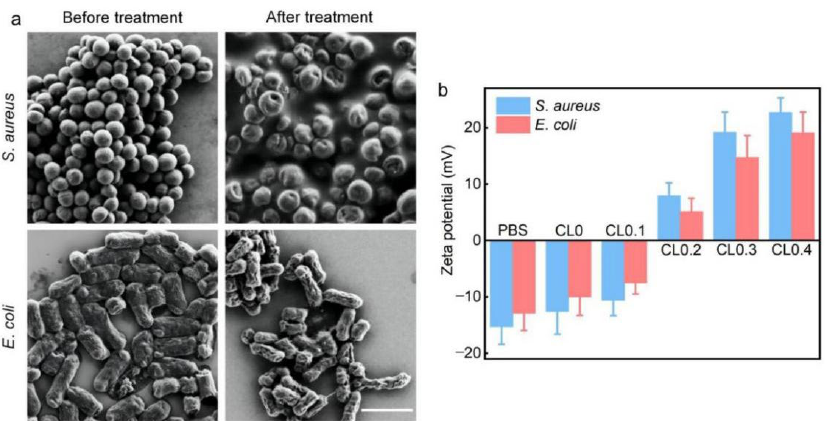
Figure 3. ( a ) SEM images of S . aureus and E . coli cells before and after the treatment of CL0.4 for 5 h. Scale bar = 2 μm. ( b ) Zeta potentials of S . aureus and E . coli bacteria after treatment with PBS or different CLs for 5 min in PBS.